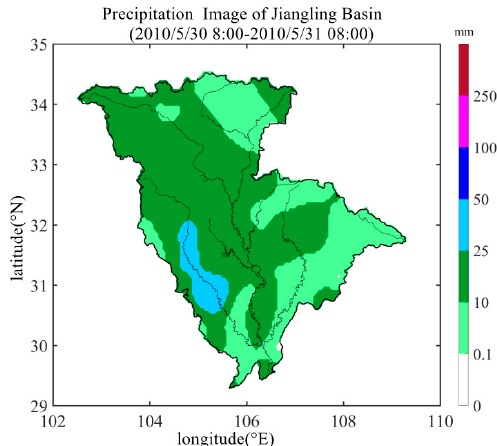
Figure 1. Example of precipitation image.